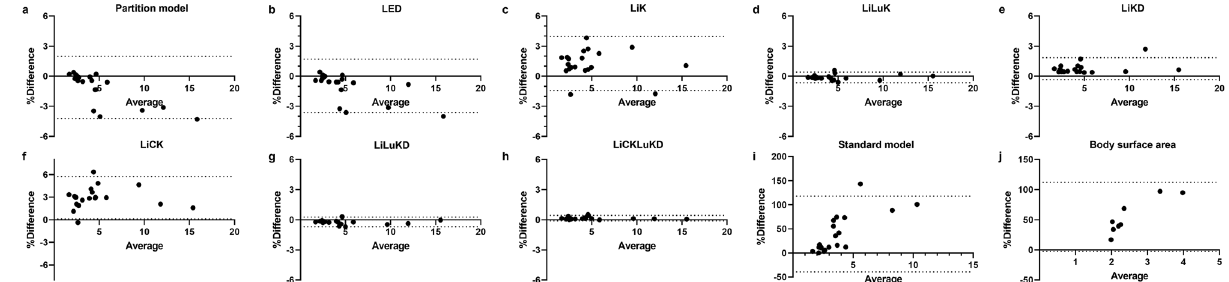
Figure 4. Bland–Altman plots with 95% confidence interval (CI) of MIA differences (%) between MC and other methods. The dashed lines represent 95% CI of mean